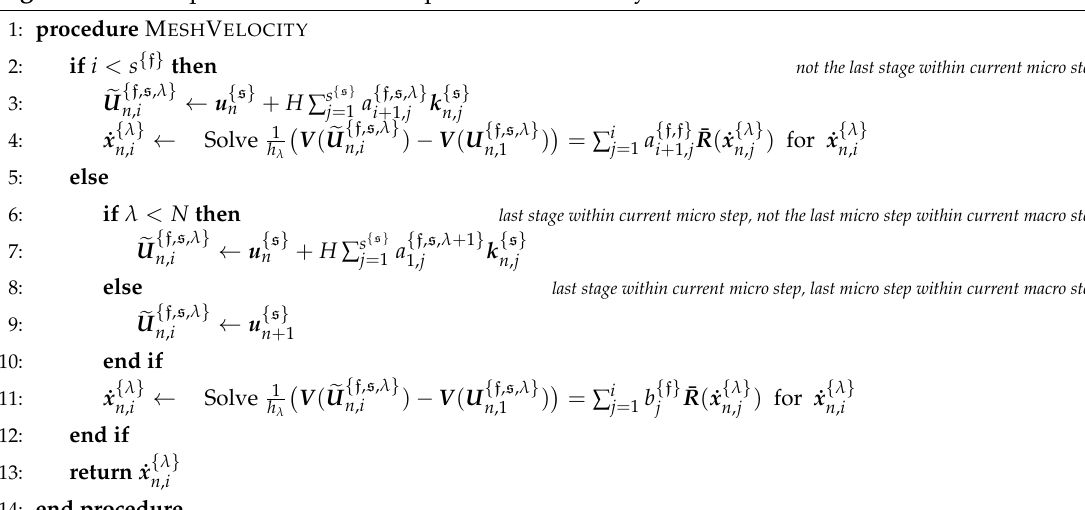
Algorithm 2 Computation of GCL-compliant mesh